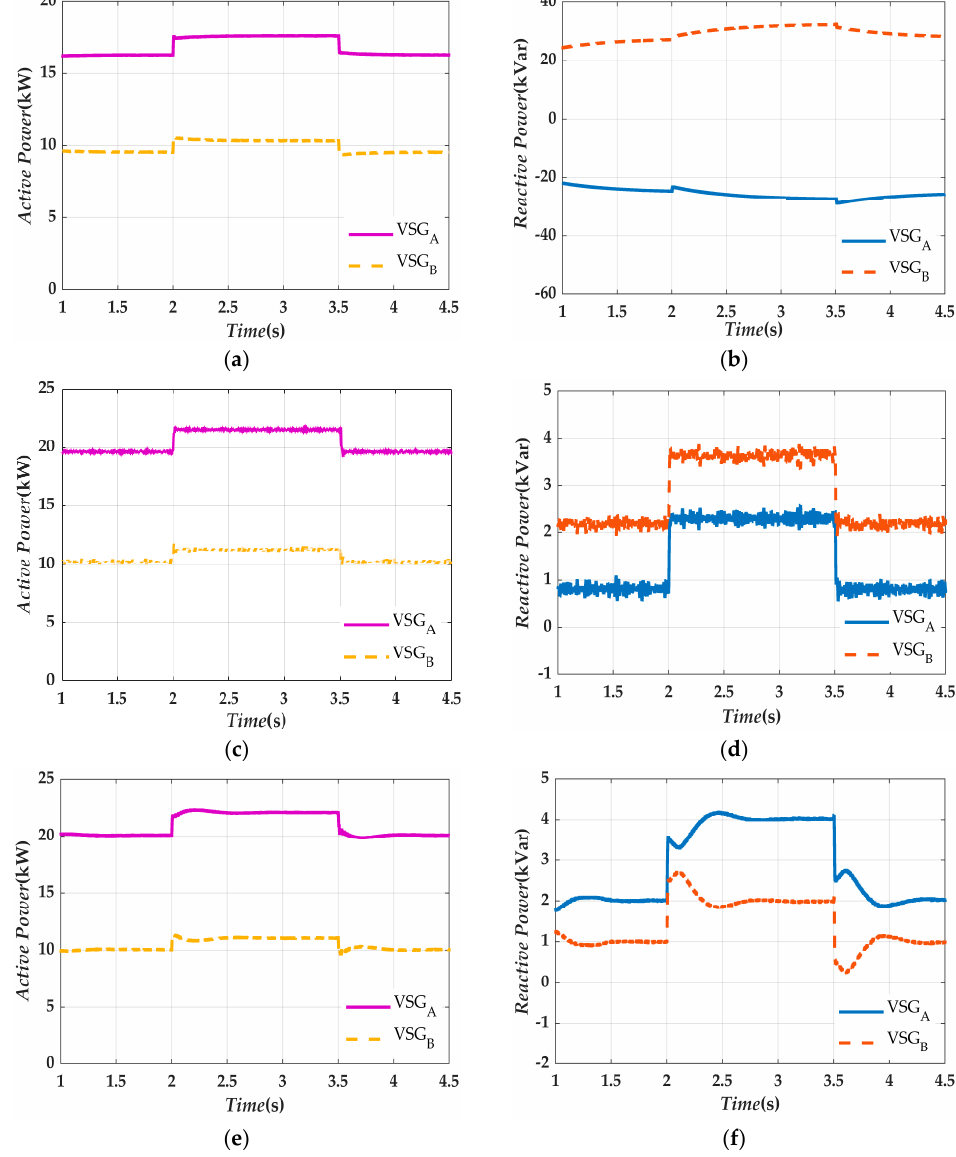
Figure 10. Waveforms of power sharing of multi-parallel self-synchronizing voltage sources: ( a ) active power sharing without decoupling method; ( b ) reactive power sharing without decoupling method; ( c ) active power sharing with virtual impedance method; ( d ) reactive power sharing with virtual impedance method; ( e ) active power sharing with improved VSG strategy and matching principle; ( f ) reactive power sharing with improved VSG strategy and matching principle.